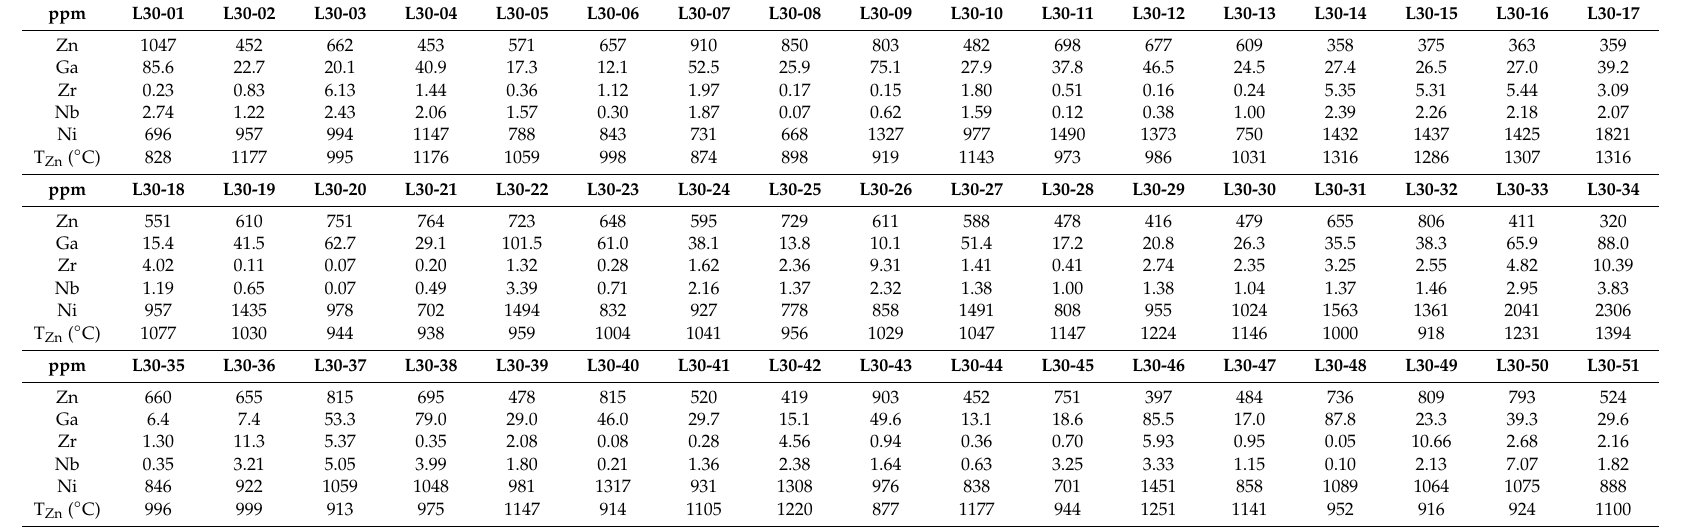
Table 2. Trace element concentrations and equilibrium temperature estimated using the Zn-in-chromite method [15] in the xenocrystic spinels from the No.30